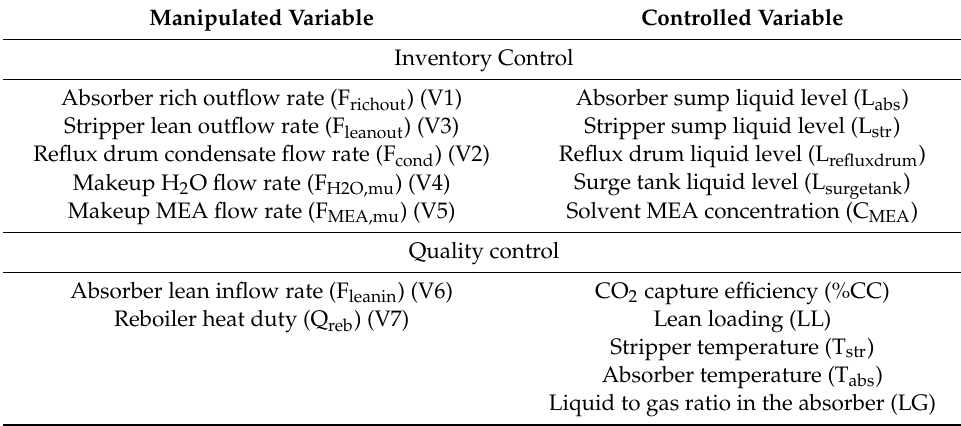
Table 1. Manipulated and controlled variables available for configuring control structures.